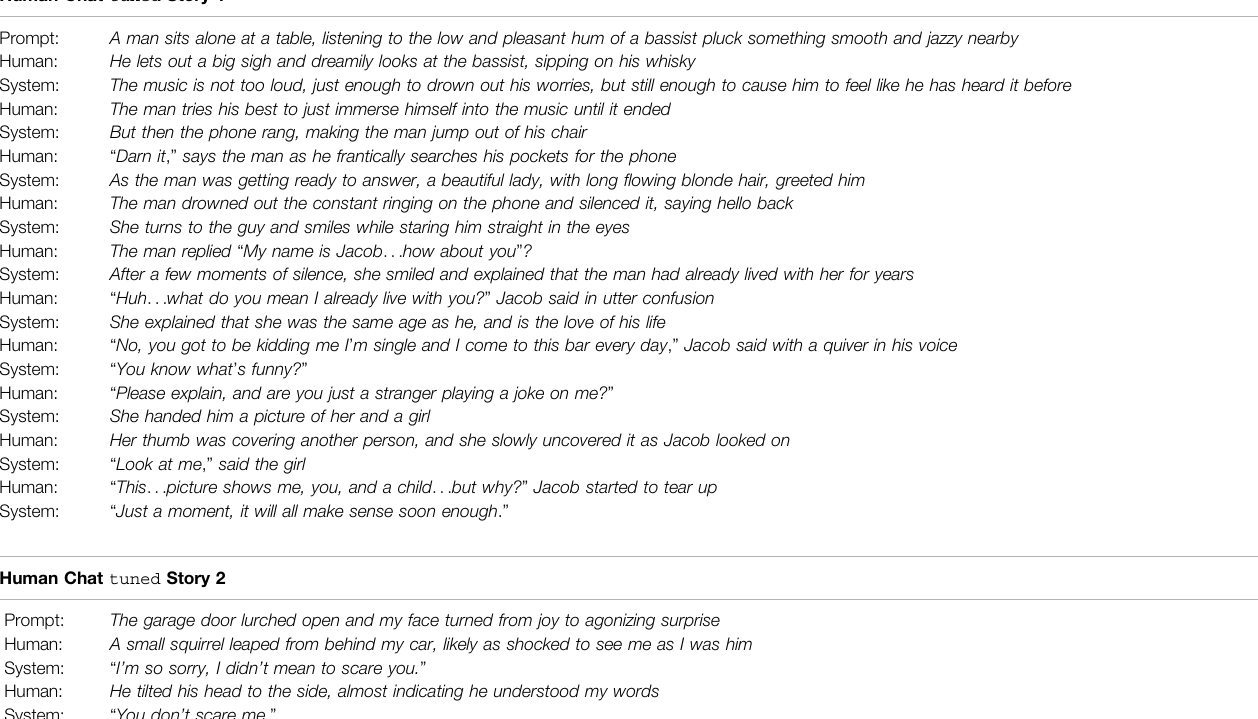
TABLE 4 | Example stories generated by the tuned system with a human through the collaborative storytelling annotation